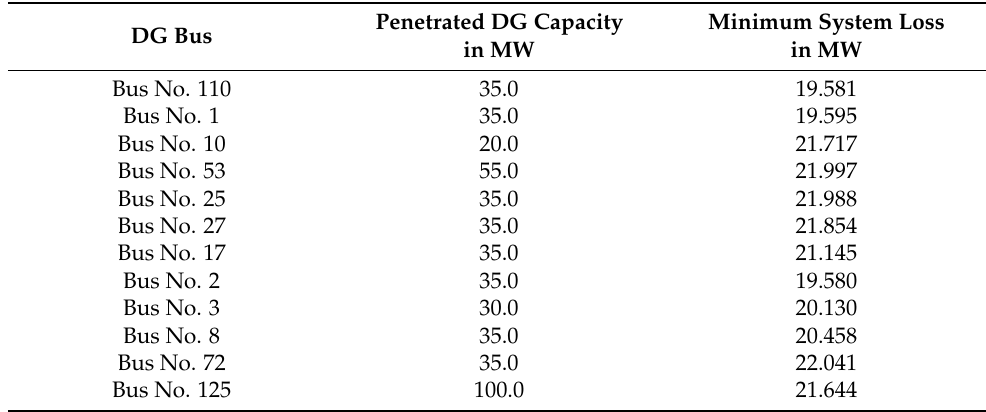
Table 11. Congestion solution tabulation through the formulated algorithm for the practical grid system with the allocation of